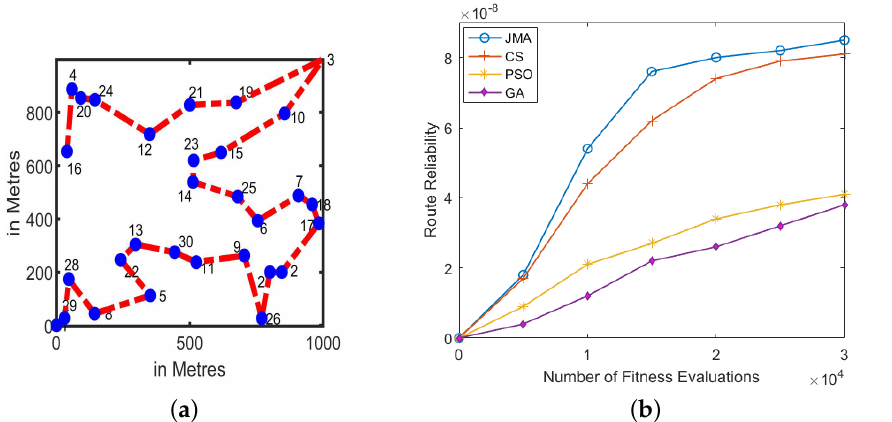
Figure 7. Medium Vehicular Density (30 vehicles). ( a ) Best route discovery achieved using JMA; ( b ) Mean route reliability results achieved across 1000 Monte Carlo trails.